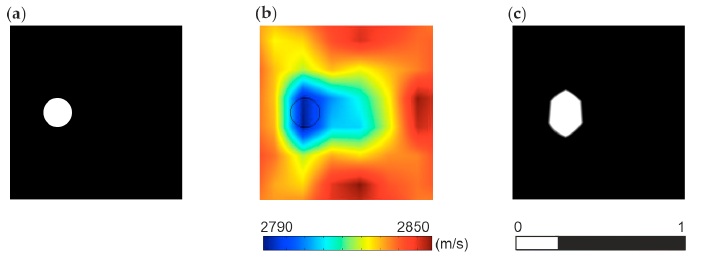
Figure 17. Error coefficient values for maps with reduced spectrum based on direct travel time measurement method: ( a ) reference model with a reduced spectrum, ( b ) topographic map with a full spectrum, ( c ) tomographic map with a reduced spectrum.